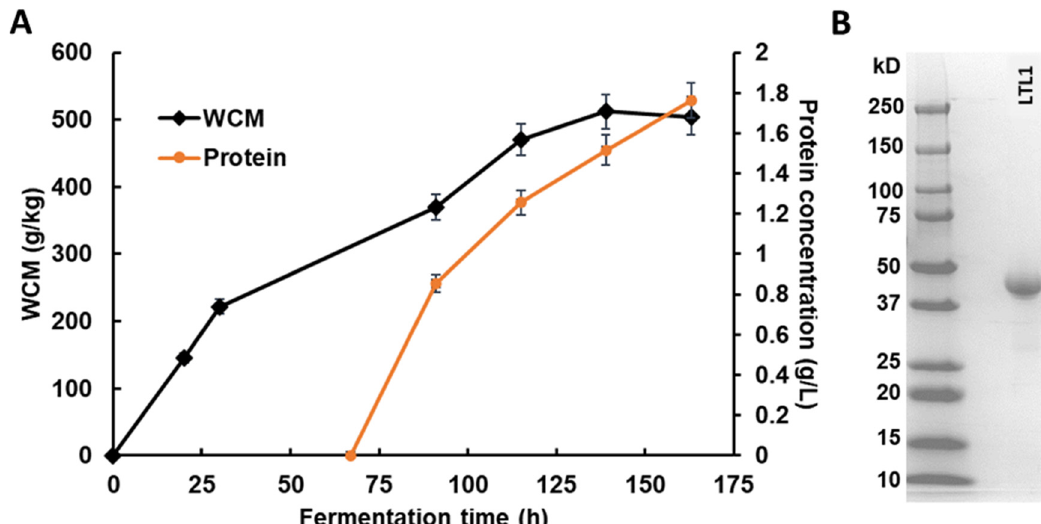
Figure 2. Heterologous protein expression of LTL1 in P. pastoris with fed-batch fermentation. ( A ) Cell growth and protein concentration for LTL1 fed-batch fermentation and ( B ) LTL1 expressed by fed-batch fermentation separated by SDS-PAGE. The wet cell mass and protein concentration of the LTL1 recombinant expression strain reached approximately 500 g/kg and 1.74 g/L, respectively. Fermentation culture separated on SDS-PAGE separated approximately 90% purity of LTL1, which was used for protein X-ray crystallisation without further purification.